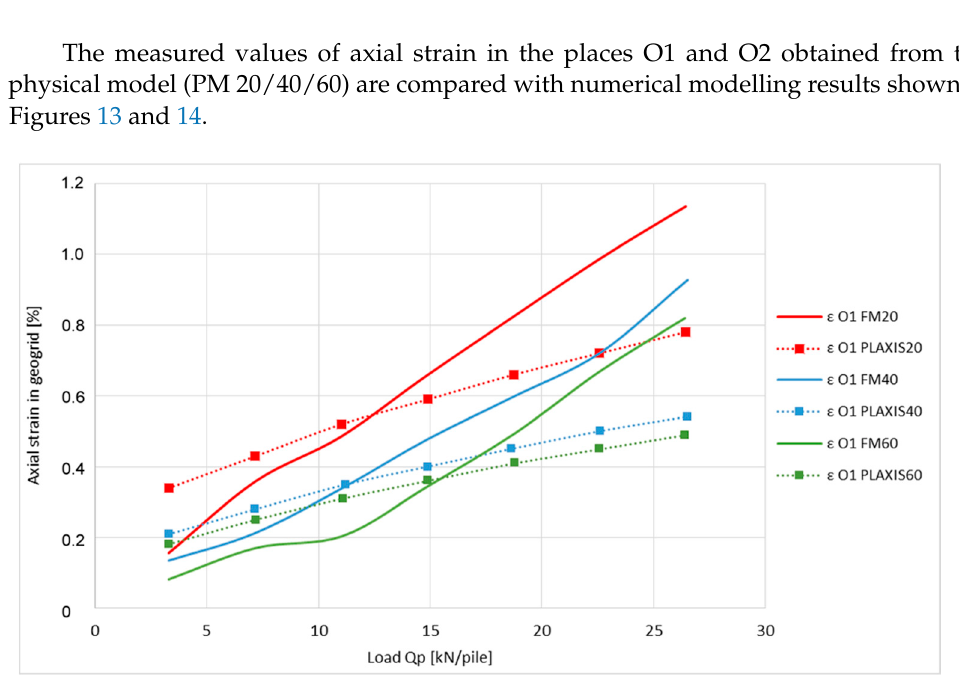
2.2 times of the measured